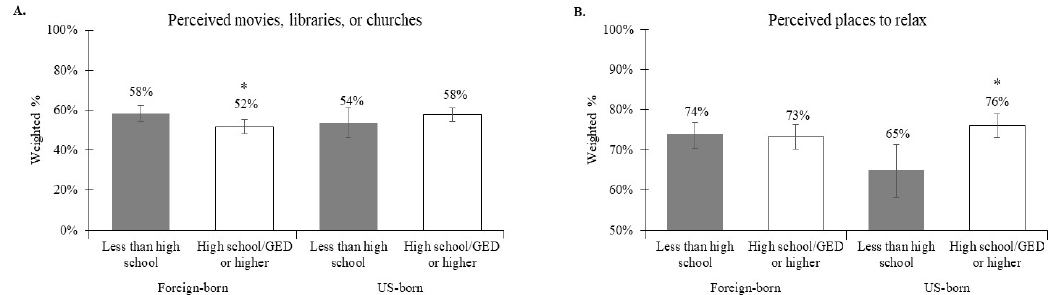
Figure 2. Interactions between nativity and education in relation to ( A ) perceived movies, libraries, or churches (interaction p = 0.03) and ( B ) perceived places to relax (interaction p = 0.008). Asterix indicates that the prevalence (95% CI) of the built environment attribute is significantly different by education for that nativity group. Table 4. Multivariate associations of socio-demographic characteristics and walking behaviors with perceived neighborhood destinations among Latinos, stratified by nativity, the NHIS 2015.